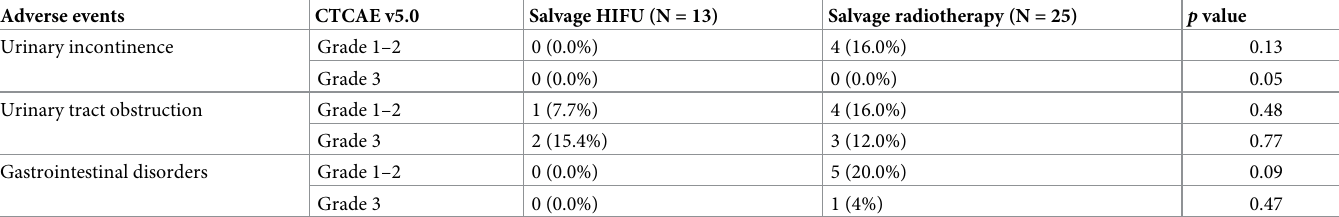
Table 8. De novo adverse events after salvage